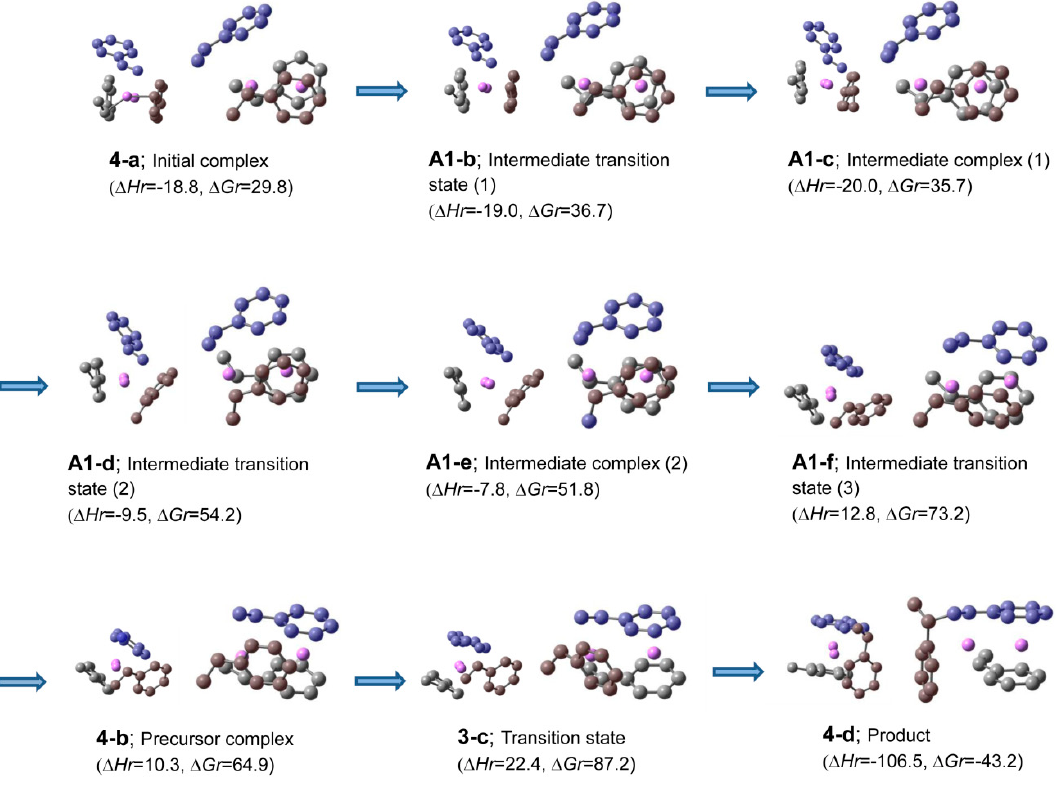
16 of 18 Table A2. Calculated electronic energies, zero-point(ZP)-corrected electronic energies, enthalpies ( H ) and Gibbs free energies ( G ) at 25 °C in cyclohexane for the transition states of the reaction of dimeric (HstLi) 2 and non-associated HStLi with styrene. Structure Designation a